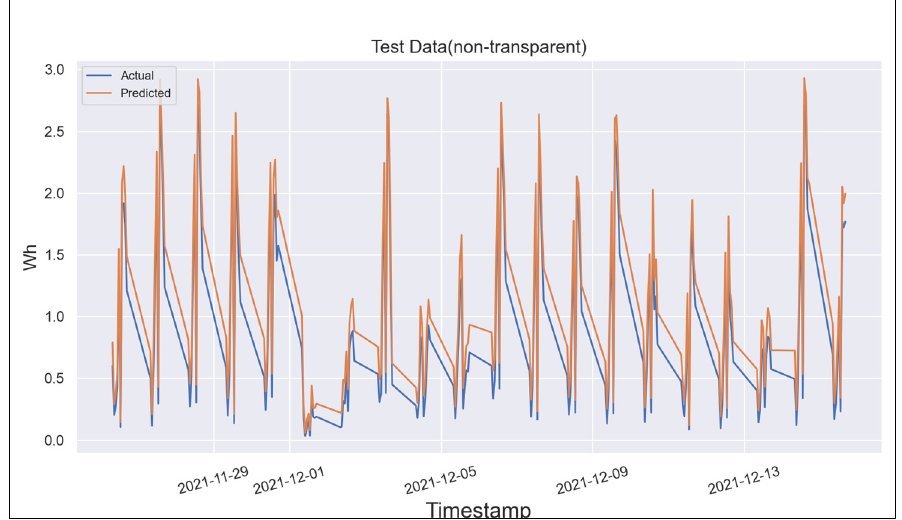
Figure 7. Transformer model test result visualization of not-transparent type module.